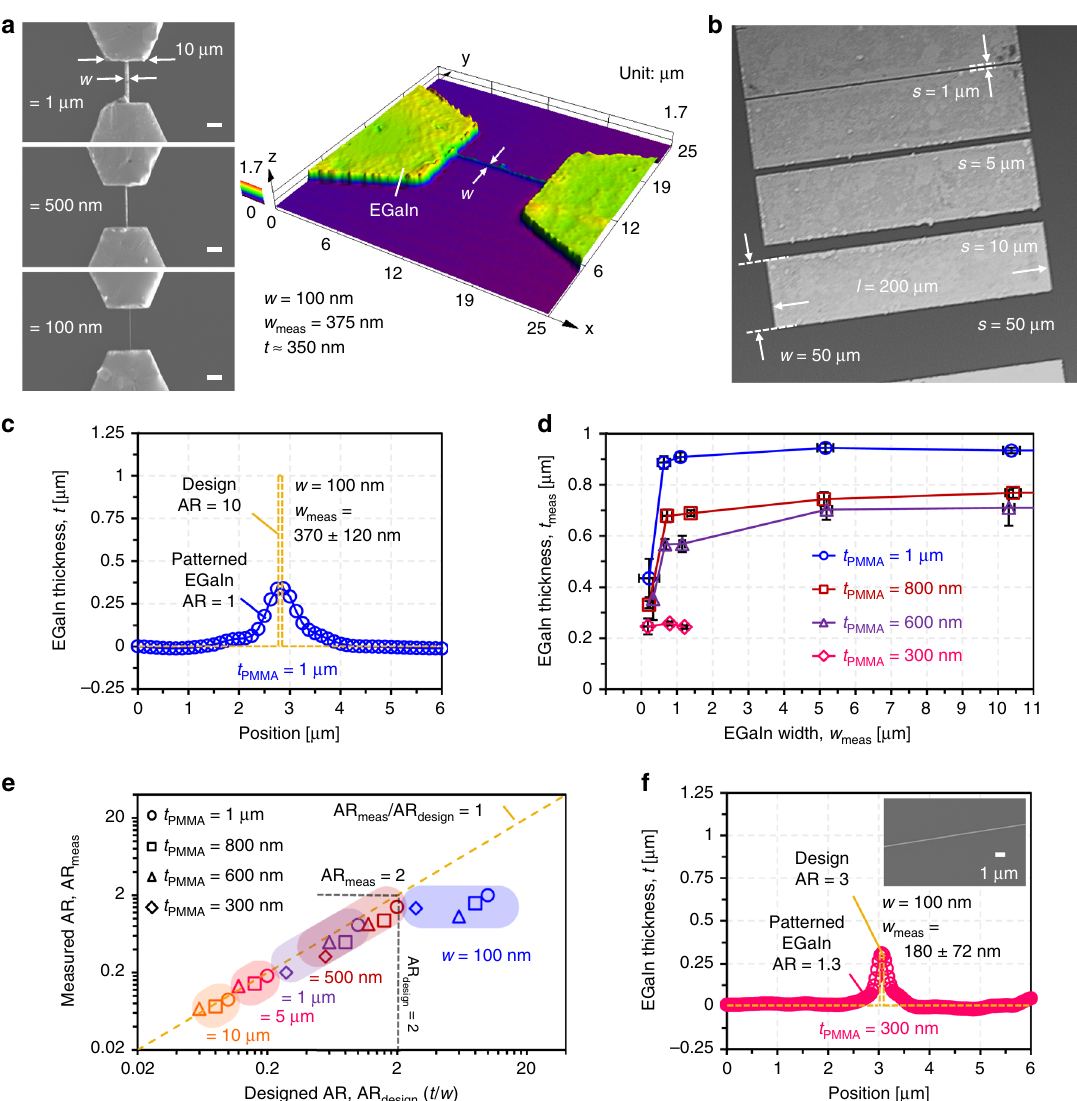
Fig. 4 EGaIn patterning performance. a SEM images of EGaIn structures with designed line widths of 1 µ m, 500 nm, and 100 nm on Si wafer as well as 3D pro fi le of 100 nm EGaIn line fabricated using 1- µ m PMMA thickness. Scale bars indicate 3 μ m. b Patterned EGaIn test structures on Si wafer to evaluate achievable line spacing. c 3D cross-sectional pro fi le of EGaIn line with designed 100-nm line width using 1 µ m PMMA thickness. d Measured thickness of fabricated EGaIn lines as a function of designed EGaIn width for different PMMA thicknesses from 1 µ m down to 300 nm. The x- and y-error bars represent the standard deviation. e Measured aspect ratio (AR) of EGaIn lines as a function of designed AR for PMMA thicknesses from 1 µ m to 300 nm. f Measured 3D cross-section of EGaIn line with a designed width of 100 nm in the case of 300 nm PMMA thickness. The inset shows an SEM image of a fabricated 180-nm-wide EGaIn